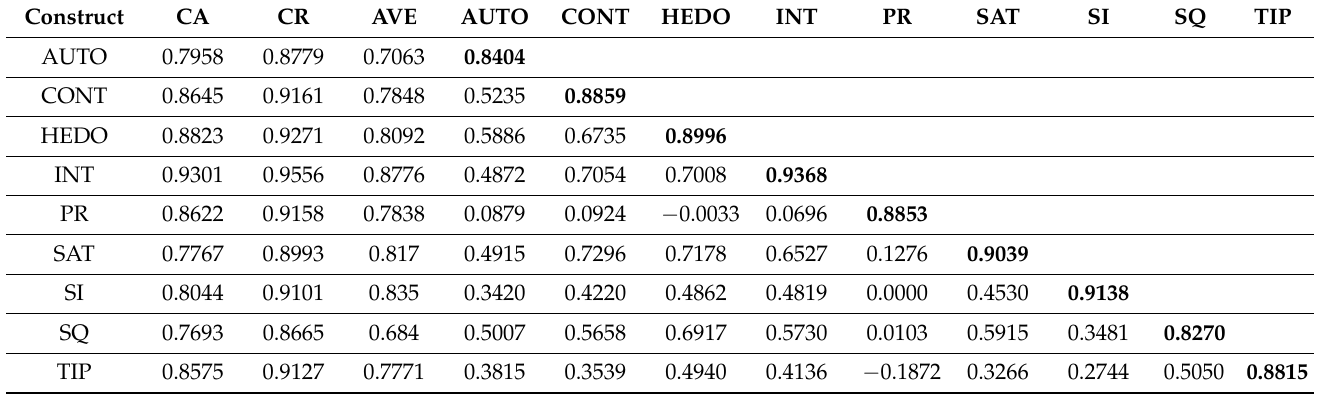
Table 2. Quality indicators and correlations with square root of AVE on the